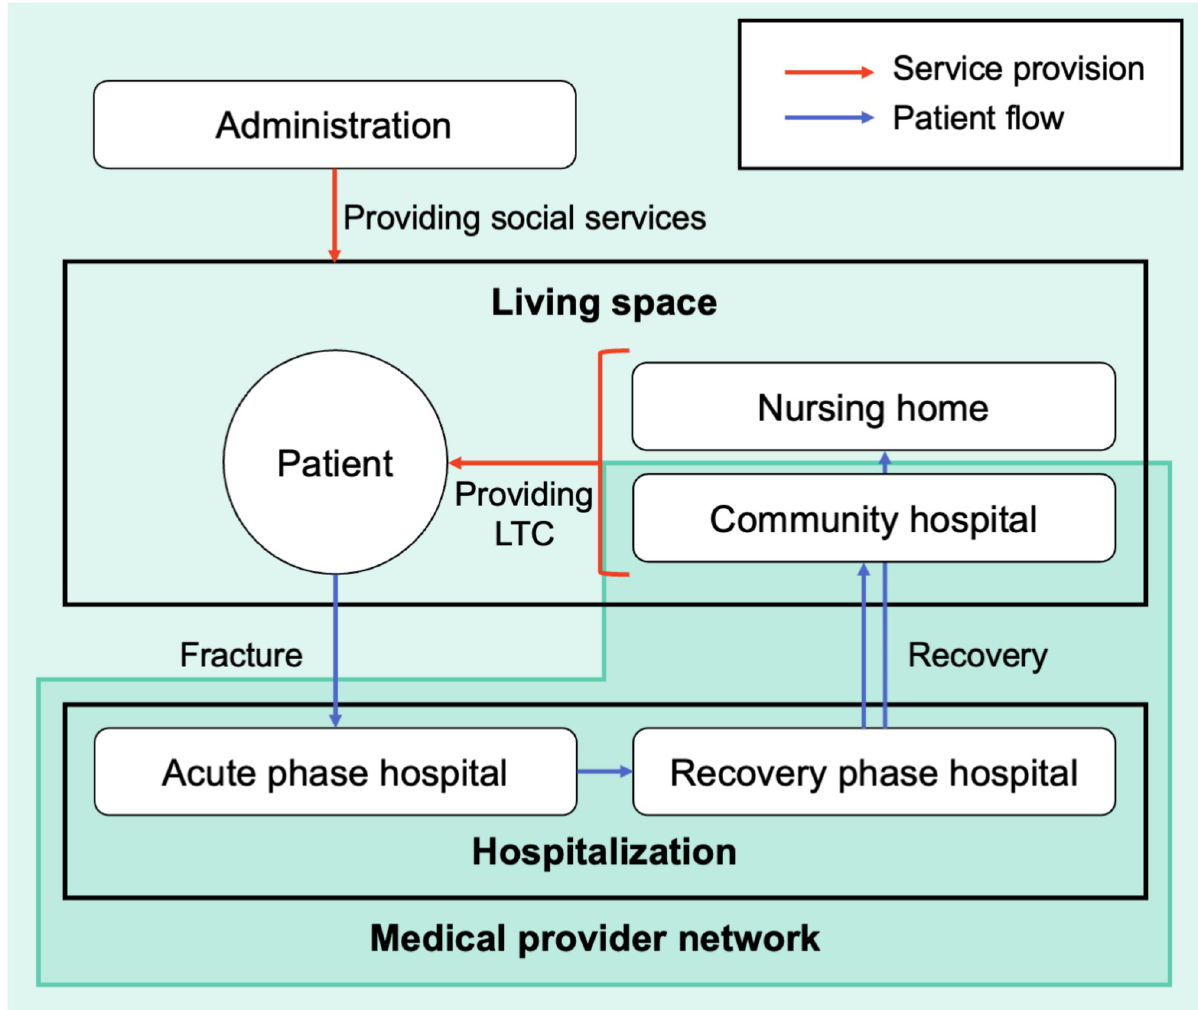
Fig 1. Conceptual diagram of regional inter-institutional medical cooperation for treating femoral neck fracture. The red arrows represent the flow of patients. The blue arrows represent the service provision relationship. Patients with femoral neck fractures are hospitalized in the acute and recovery phase hospitals. Community hospitals and nursing homes provide long-term care (LTC) after discharge. The administration provides social services to maintain and improve the health of patients before and after a